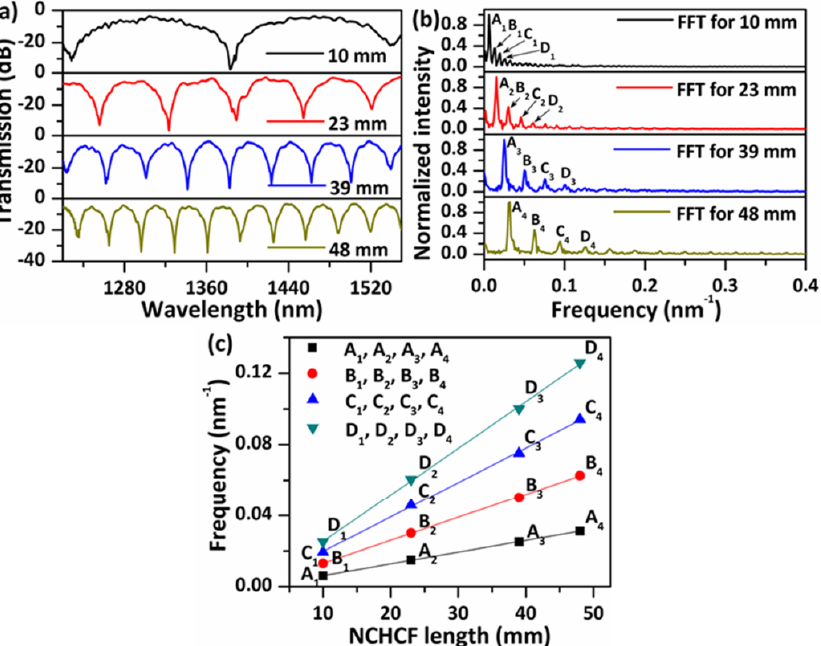
Figure 3. ( a ) Measured transmission spectra and ( b ) fast Fourier transform (FFT) spatial frequency spectra corresponding to those in ( a ), and ( c ) spatial frequency variations versus the NCHCF length.